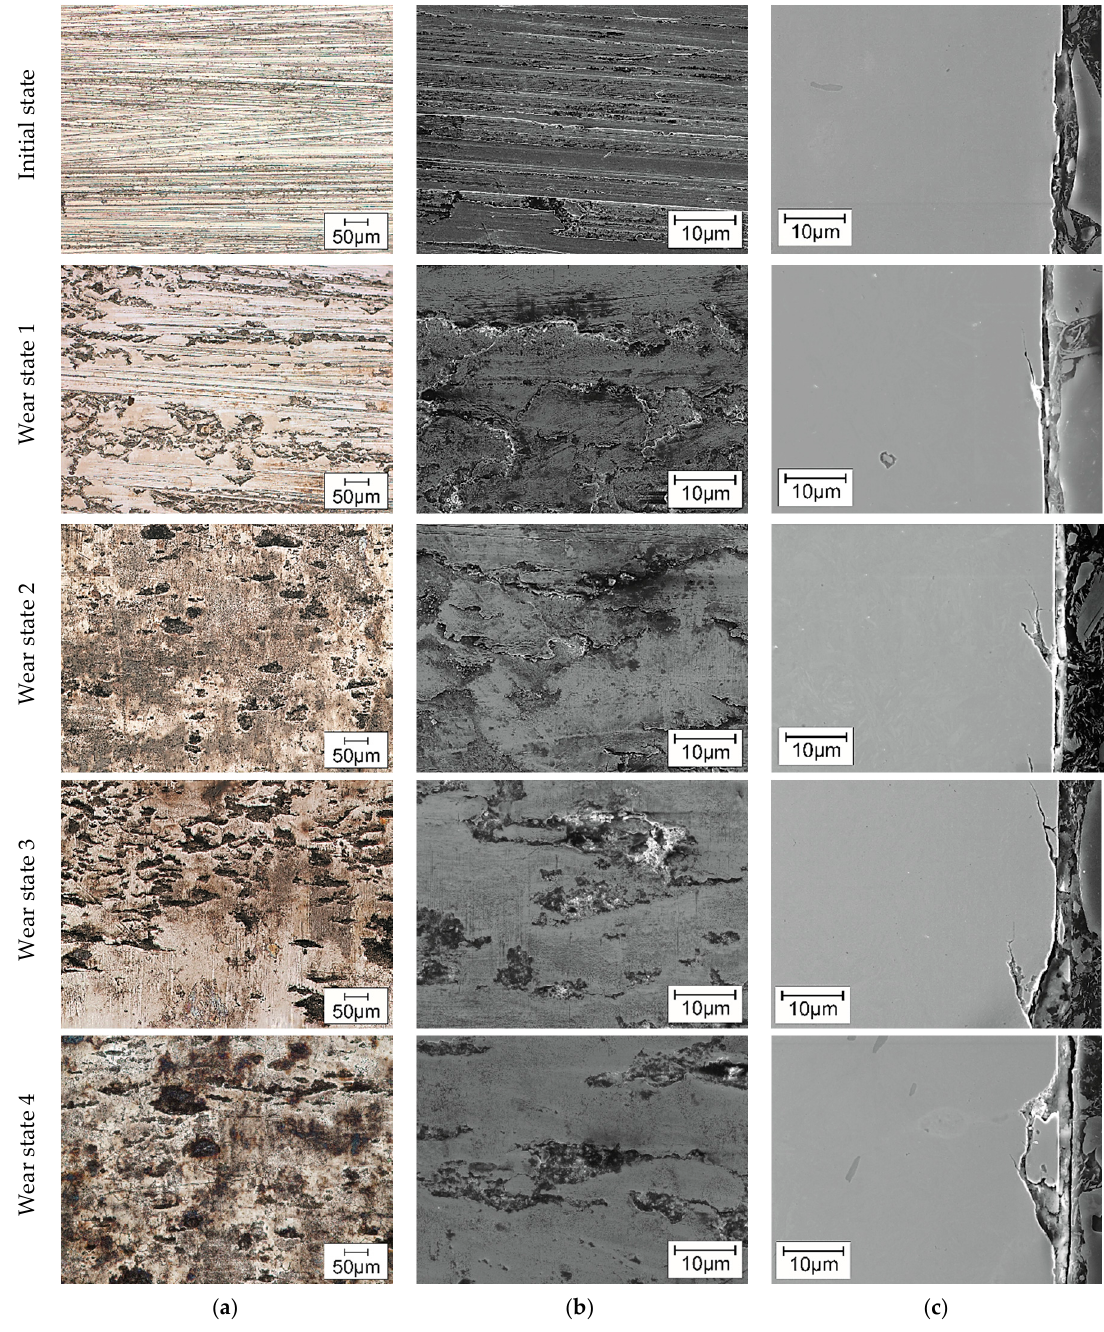
Figure 8. Microstructural characterization of wear in gear teeth by means of: ( a ) light microscope (200×) in area F2; ( b ) SEM on the surface (2000×) in area F2; ( c ) SEM on cross-section (2000×) in area CS1.